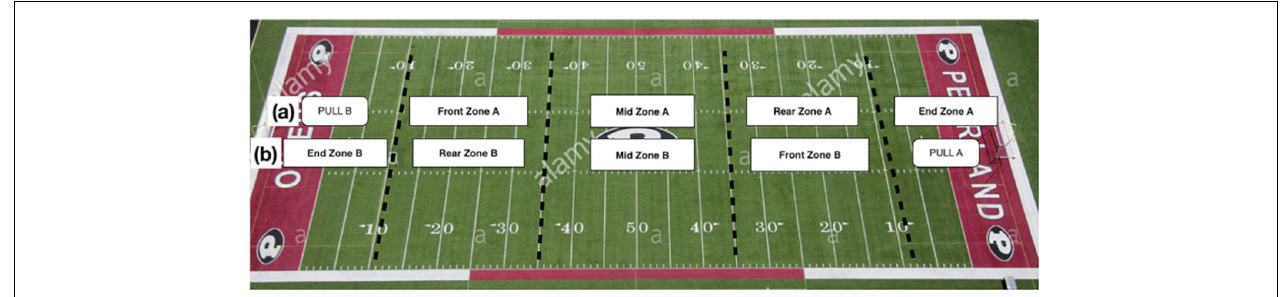
FIGURE 2 | Transient states in the state transition model for Ultimate. (a) When Team B pulls and Team A starts with possession of the disc. (b) When Team A pulls and Team B starts with the